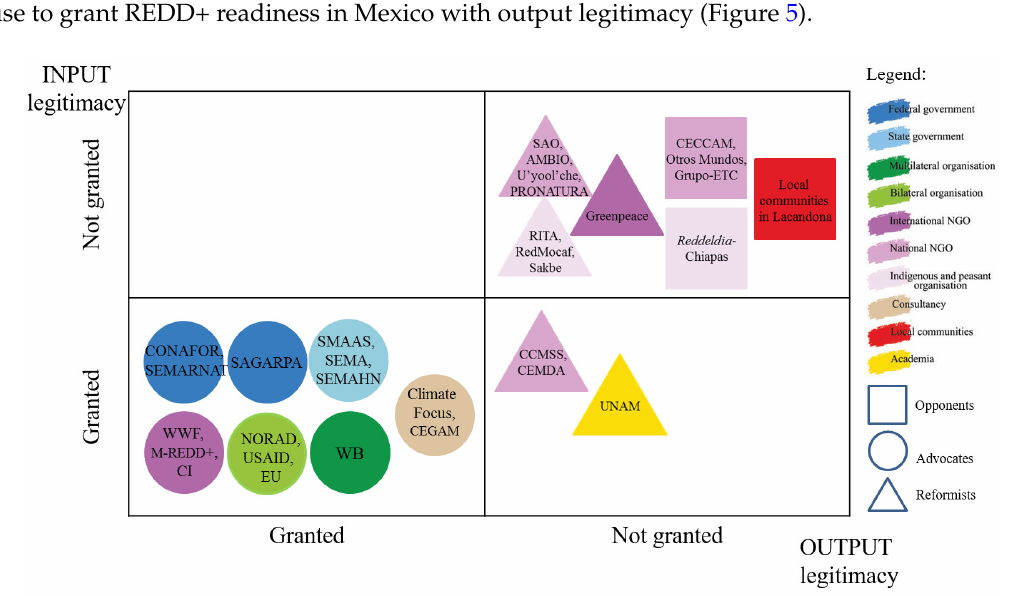
Figure 5. Correlation between the actors’ sector, discourse, and perception on the input and output legitimacy of REDD+ governance in Mexico. Source: own elaboration.